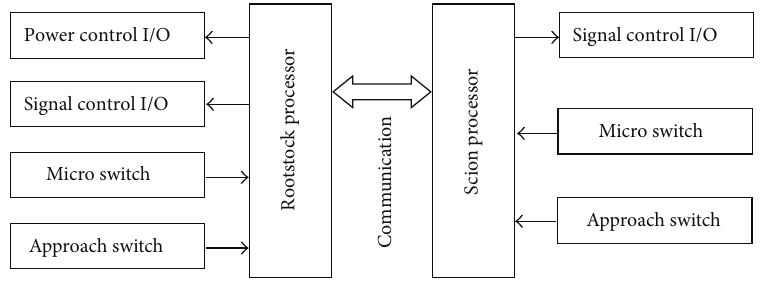
Figure 11: Structure of the control system.